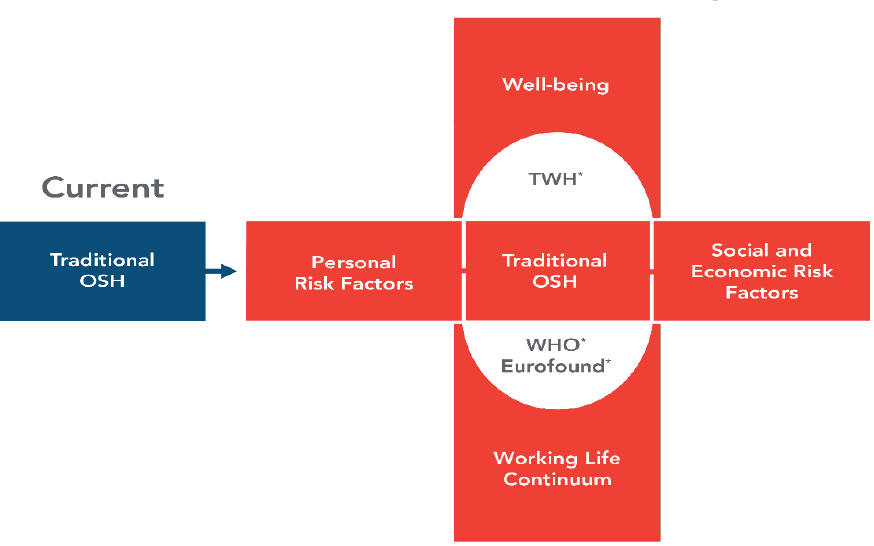
Figure 1. Model for an expanded focus for the occupational safety and health field [18,19].